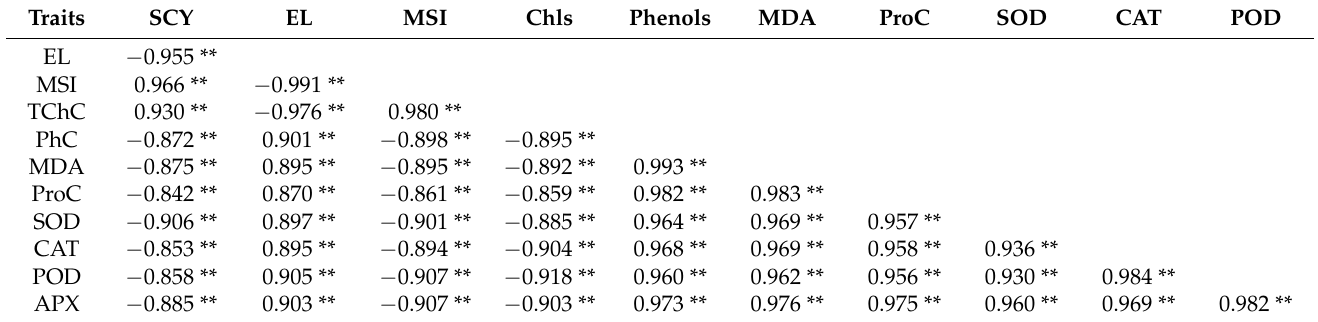
Table 6. Correlation coeffecients and p -values among seed cotton yield, physiological and antioxidant traits under different water regimes (WRs) on sandy soil